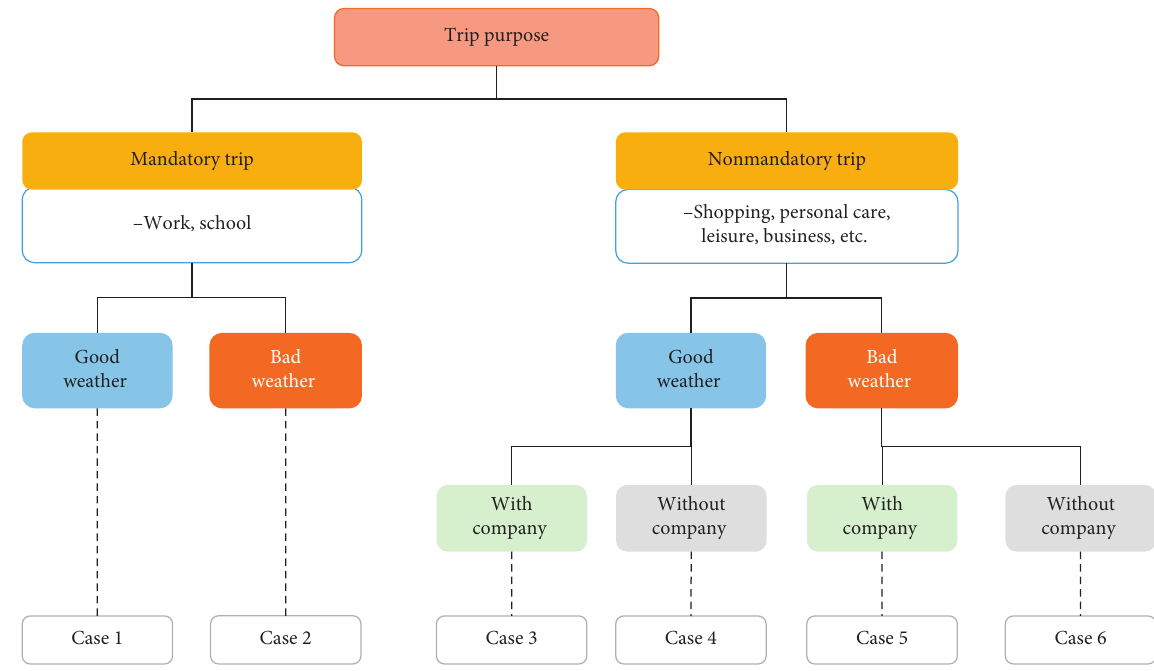
Figure 4: Case tree for mode choice